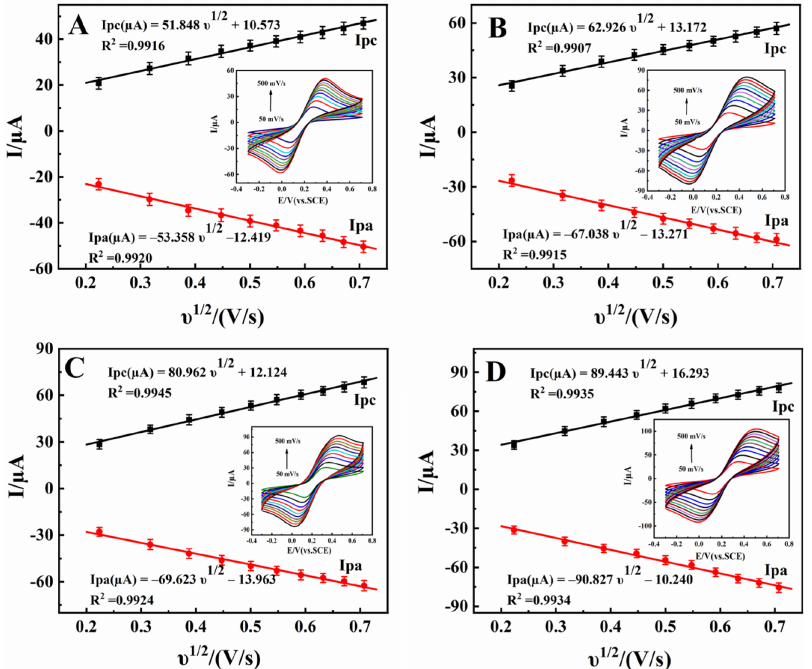
Figure 4. Relationship of Ip and υ 1/2 of ( A ) SPE, ( B ) ND/SPE, ( C ) BP/SPE, and ( D ) ND@BP/SPE. Inset is the CV of different electrodes in a 1.0 mmol/L K 3 [Fe(CN) 6 ] and 0.5 mol/L KCl mixture with different scan rates from 50 to 500